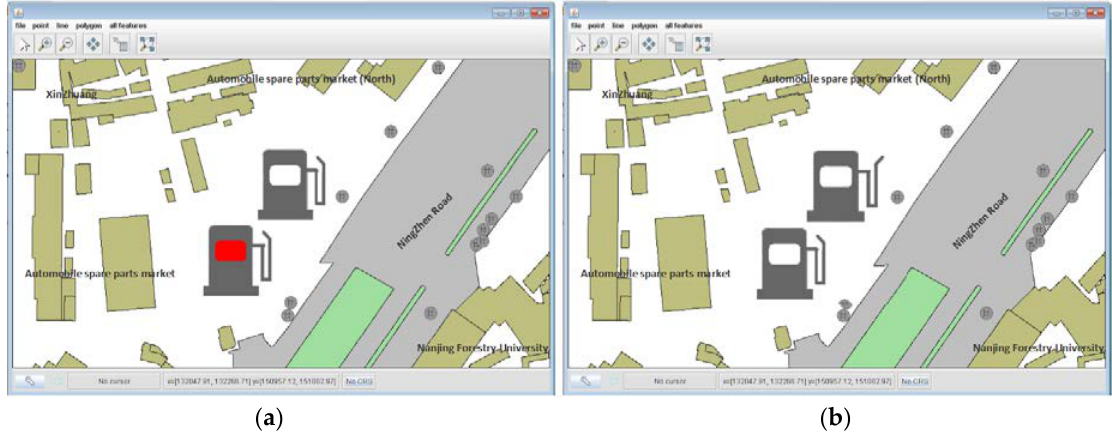
Figure 7. Real-time geo-sensor data visualizations in the client-server architecture, using a gas station as an example. ( a ) When the oil mass of gasoline pump is lower than the threshold, the color of the graphic element changes. ( b ) When the gasoline pump is filling, the shape of the graphic element changes.